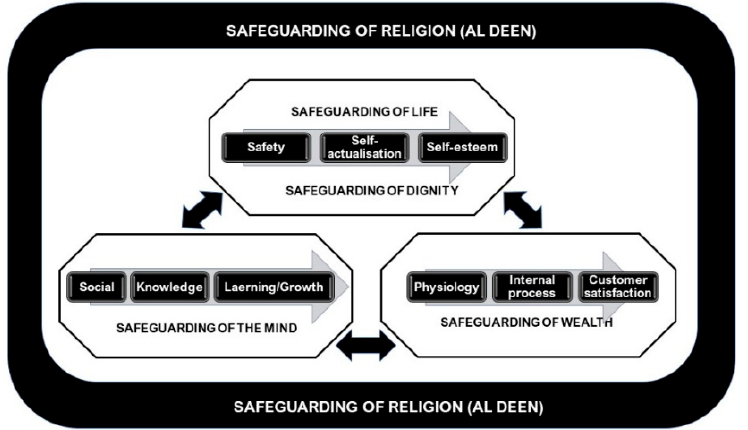
Figure 1. The Employees-Organizational Performance Needs Model (EOPNM): Maslow’s Hierarchy of Needs and Balanced Scorecard as mapped by Maqasid al-Shari’ah.